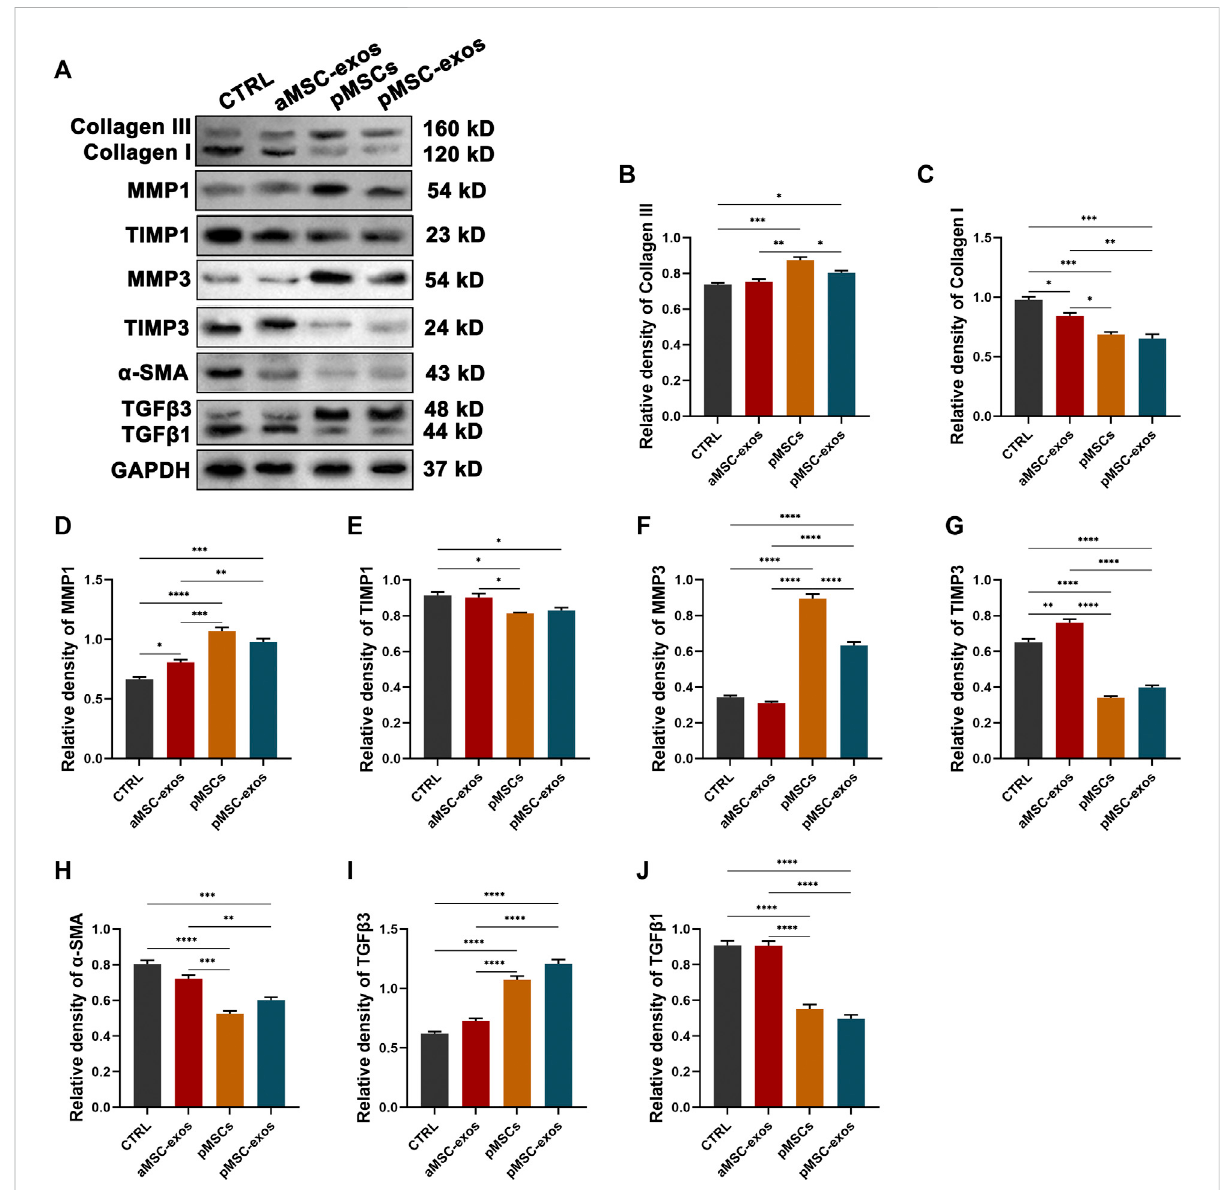
FIGURE 7 pMSC-exos improve the expressions of fi broblast and ECM remodeling associated genes in wound healing. (A) Protein (collagen III, collagen I, MMP1,TIMP1,MMP3,TIMP3,and α -SMA)levelsinthehealedskinviawesternblot. (B – J) Relativedensityofproteinbandsin (A) .Mean±SEM;* p <